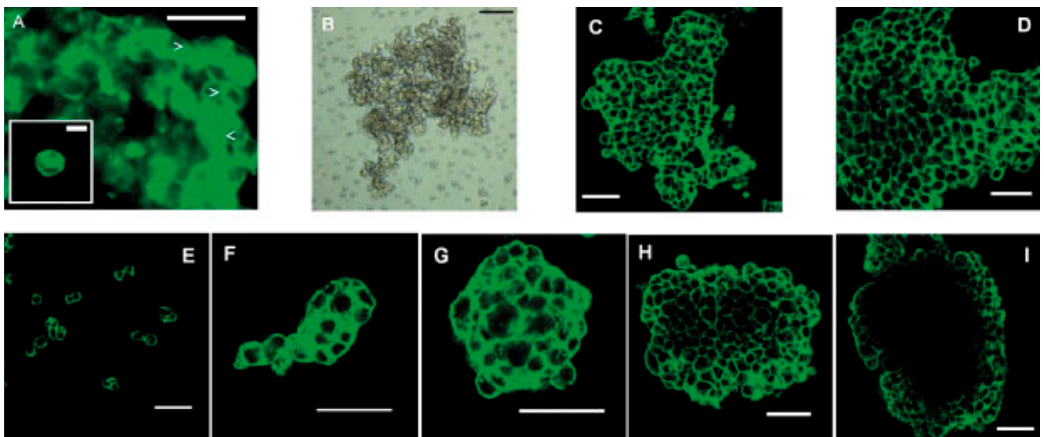
Figure 5. ( A ) Epifluorescence micrograph of 3D HepG2 aggregates by ultrasound standing wave and F-actin stained with Phalloidin-Alexa 488 with junctional F-actin marked with arrowheads (bar 25 μ m) and an unsonicated single cell shown in inset (bar 10 μ m); ( B ) aggregate maintained on a P-HEMA-coated surface after 1 day under light microscope, confocal micrograph of F-actin staining after 1 day ( C ) and 18 days ( D ); and confocal micrograph of F-actin staining in gyrotatory-produced aggregates after ( E ) 2 h; ( F ) 1 day; ( G ) 3 days; ( H ) 9 days and ( I ) 18 days ( B – I , bar 50 μ m), courtesy of [77].